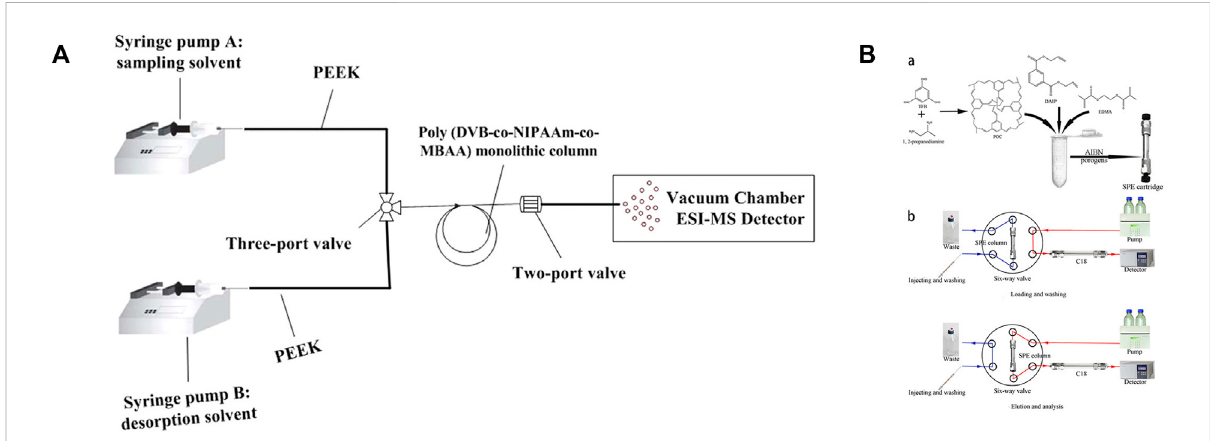
FIGURE 6 (A) :Construction oftheonline in-tubeSPME-MS system. ReprintedwithpermissionfromRef.(Wu etal.,2019).Copyright2019Elsevier (B) :SPE column synthesis scheme (A) and the SPE – HPLC procedures (B) . Reprinted with permission from Ref. (Wang L. et al., 2021). Copyright 2021